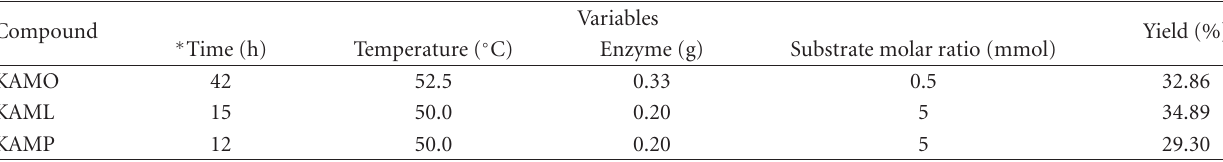
Table 1: The yield of KA esters synthesized by enzymatic esterification using immobilized lipase from Rhizomucor miehei at optimal reaction condition.